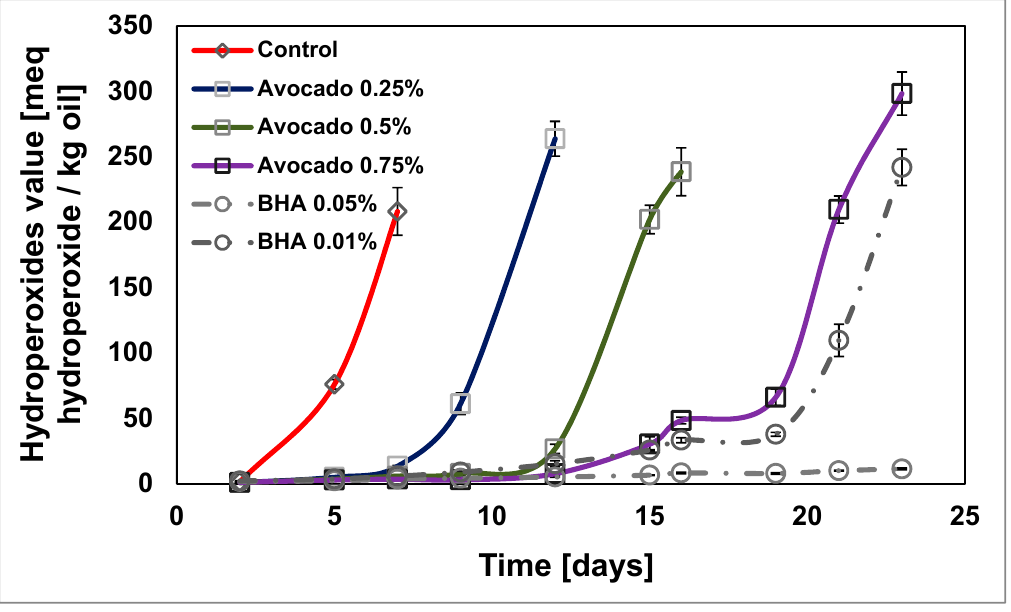
Figure 2. Changes in the peroxide value (PV) of a sunflower oil fatty acid mixture at 35 ◦ C. Table 4. Parameters of the different methods to calculate the antioxidant Table 4. Parameters of the different methods to calculate the antioxidant activity.